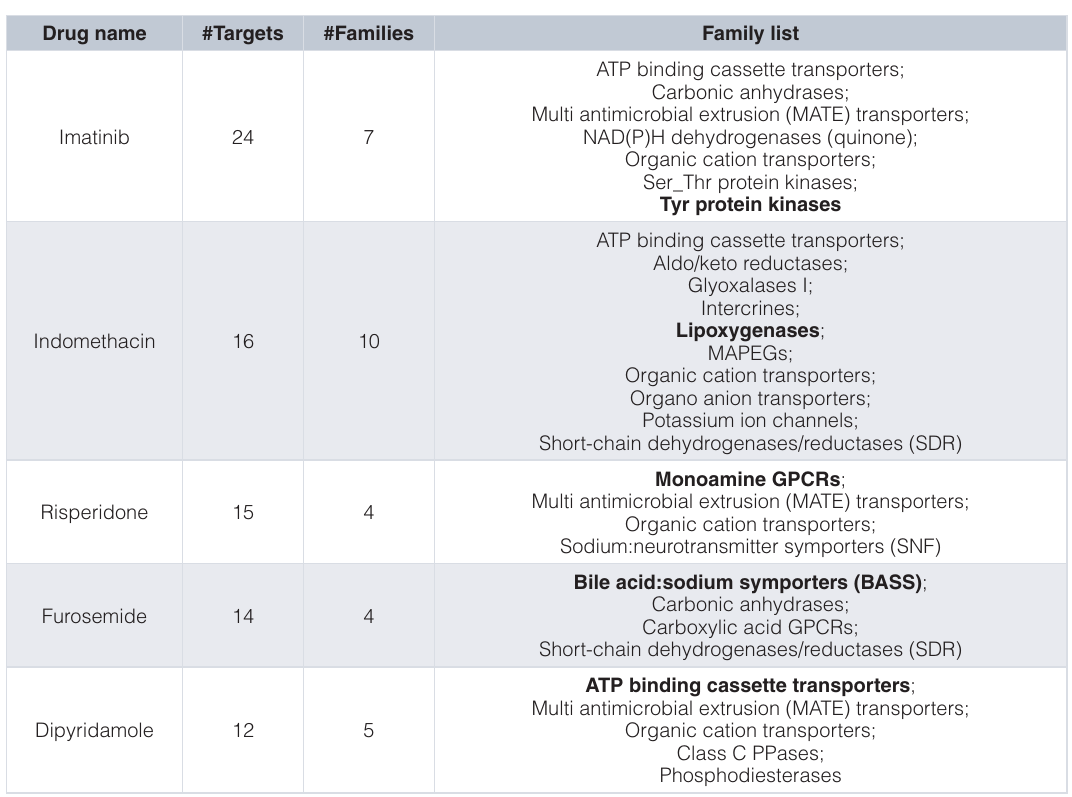
Table 4. Target family profiles for top five drugs with largest changes in promiscuity.